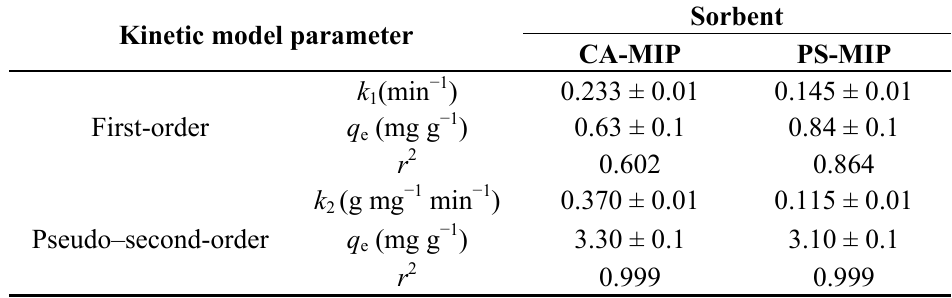
Table 1. Kinetic parameters for the sorption of 2,4-DNP by CA-MIP and PS-MIP.